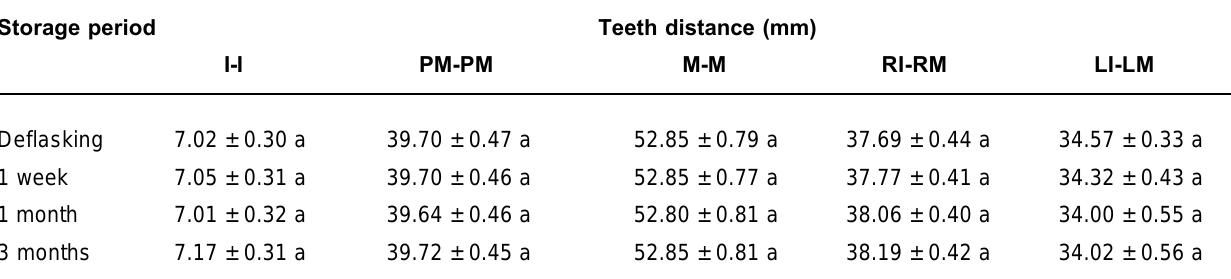
TABLE 2 - Means ± SD of teeth movement (mm) for the deflasking and water storage periods, in relation to distance Storage period